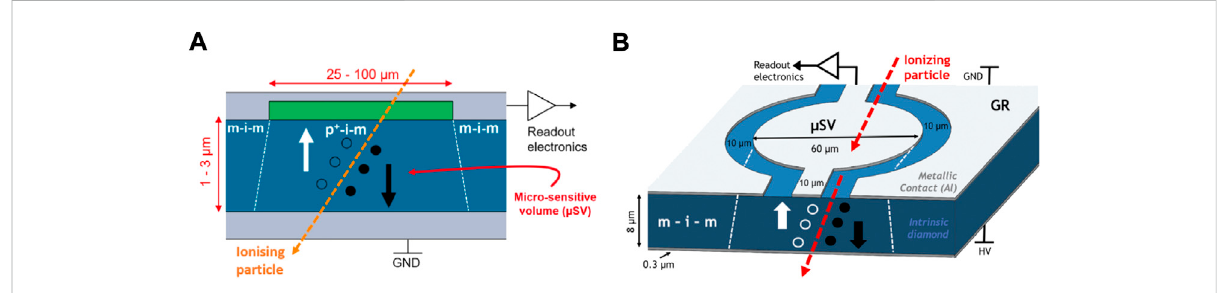
FIGURE 11 Detectorstructureofthediamond-basedmicrodosimetersdevelopedbyCEA ’ sLCD. (A) Schemeofthedoublejunctionp-i-m/m-i-mdiamond